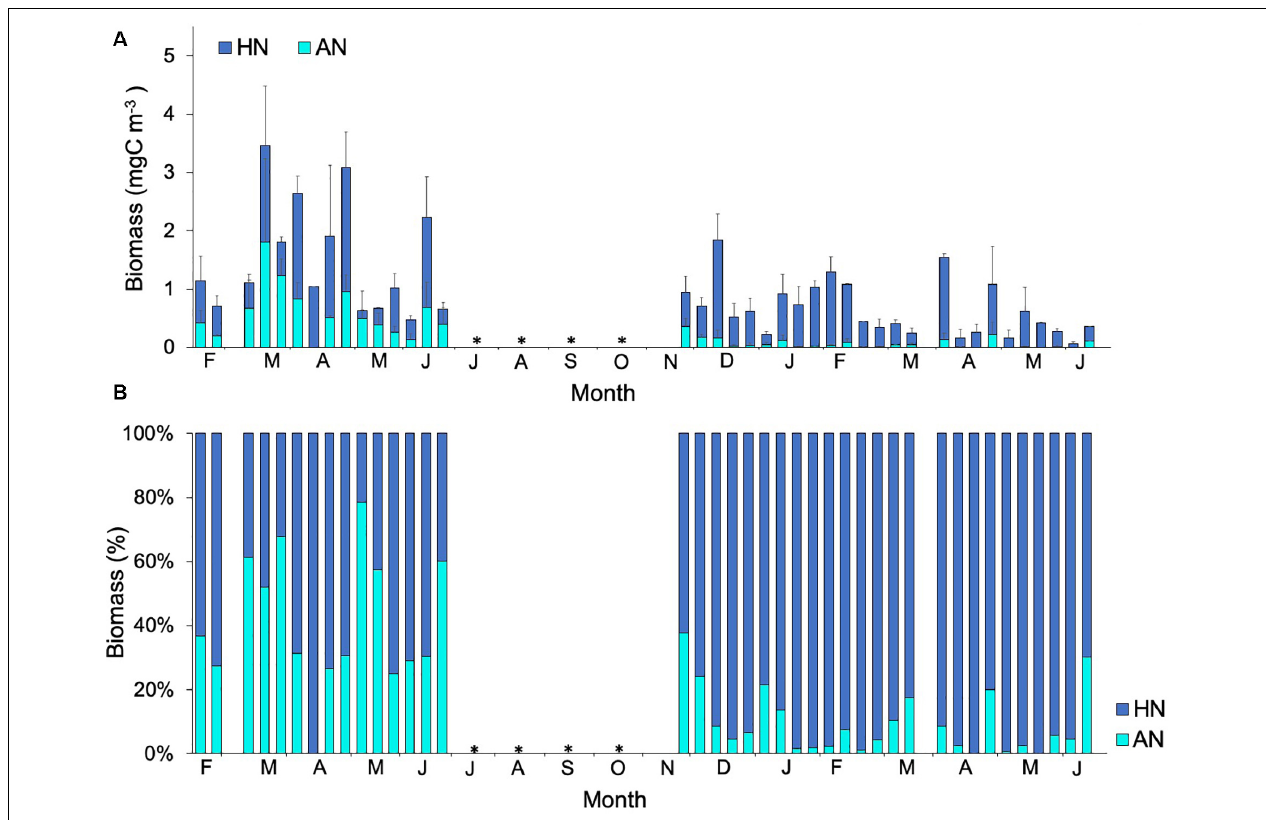
FIGURE 6 | (A) Temporal variability of averages values (mean ± SE) of biomass for stations 1, 2, and 3, and (B) Percentage for heterotrophic (HN, (cid:4) ) and autotrophic (AN, (cid:4) ) nanoflagellates. No data available is represented by an asterisk.